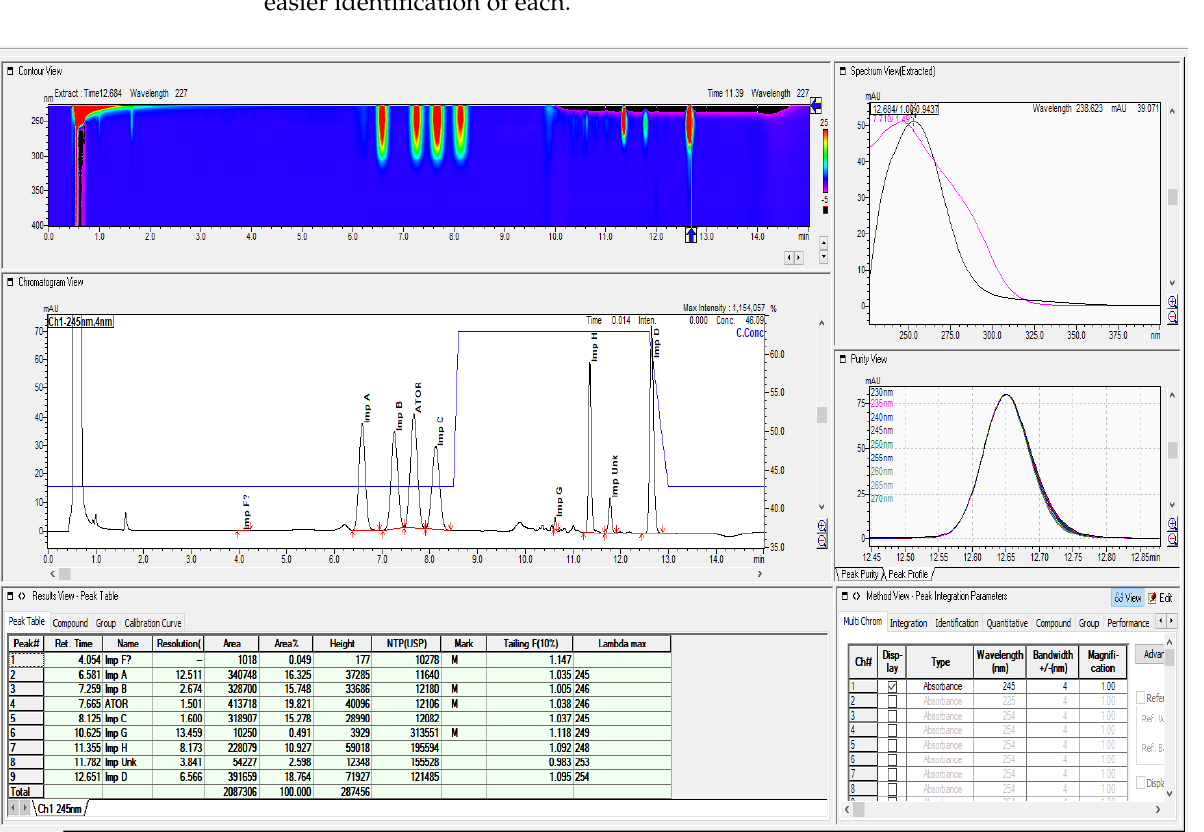
Figure 2. Chromatogram of the combined mixture of atorvastatin impurities, with plotted gradient shape and separate contour diagram at the top, extracted measuring channel at 245 nm, with a table of system suitability and peak purity parameters (obtained on Nexera-i 2040c-3D in a 15-min run). Table 1. Relative retention times (RRTs) of specified impurities of atorvastatin obtained with the EP method (retention time of atorvastatin of about 33 min) and this new developed method (retention time of atorvastatin of about 7.5 min). Specified Impurities of